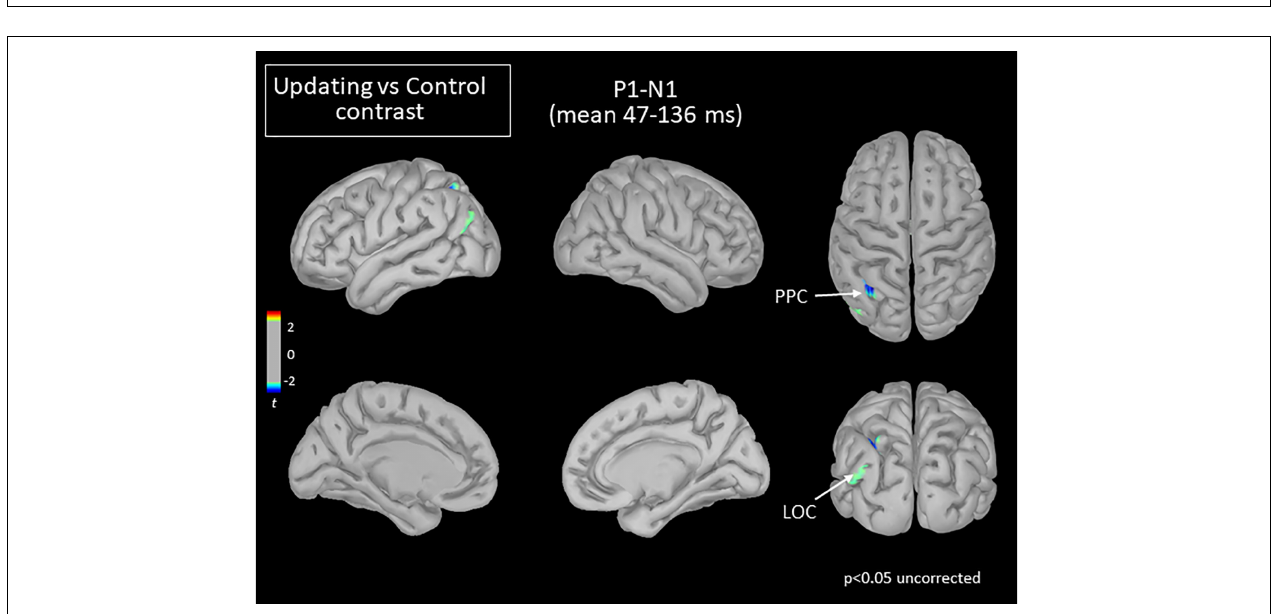
FIGURE 5 | Statistical map (cortex only, p < 0.05 uncorrected) for the Updating vs. Control contrast computed during the P 1 N 1 component of the RotEP. The t -test analysis did not reveal significant effect when correcting for multiple comparisons (FDR correction). PPC, posterior parietal cortex; LOC, lateral occipital cortex.